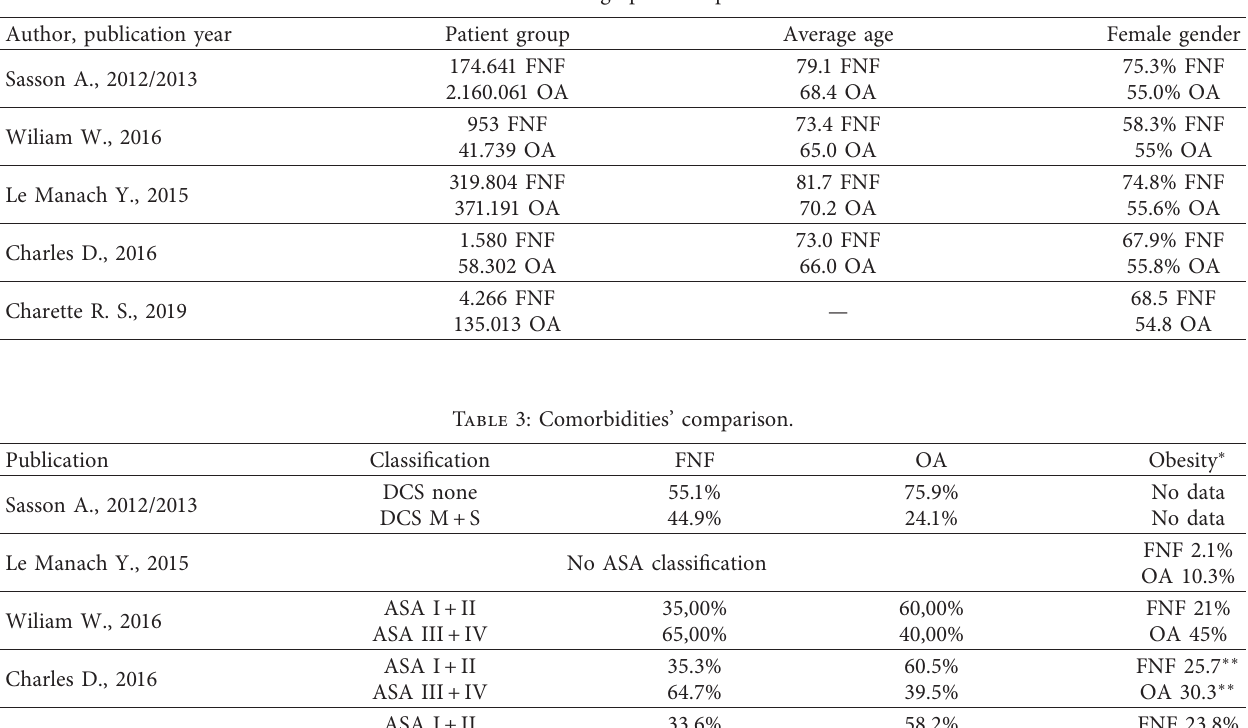
Table 2: Demographic comparison.